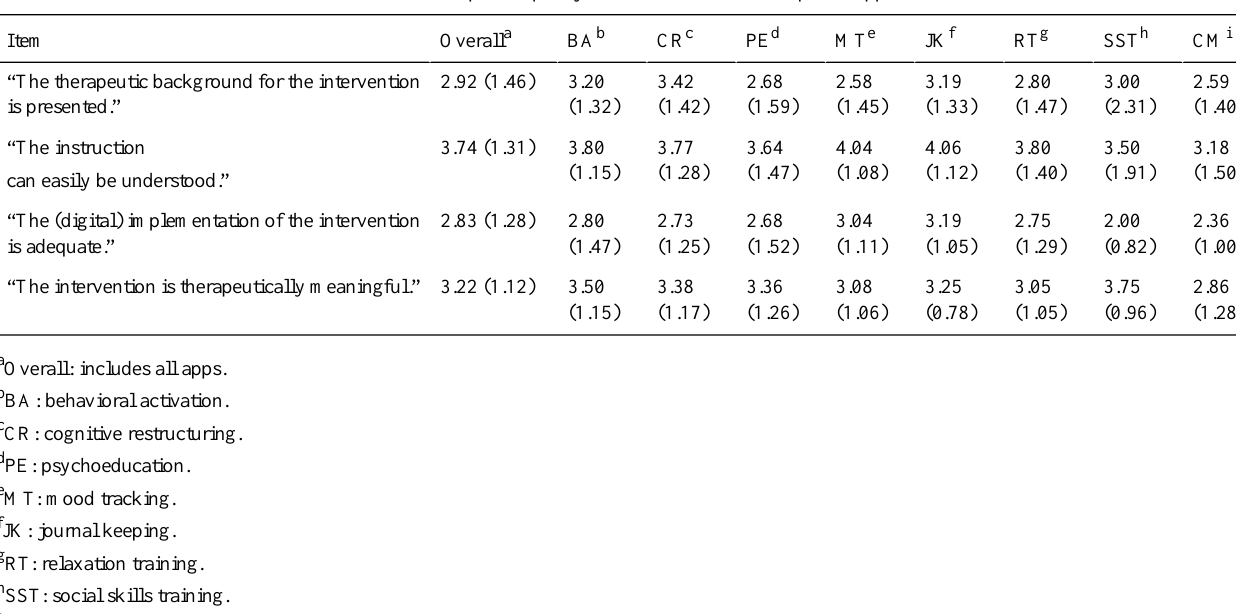
Table 4. Mean (SD) scores on assessments of the therapeutic quality in interventions of smartphone